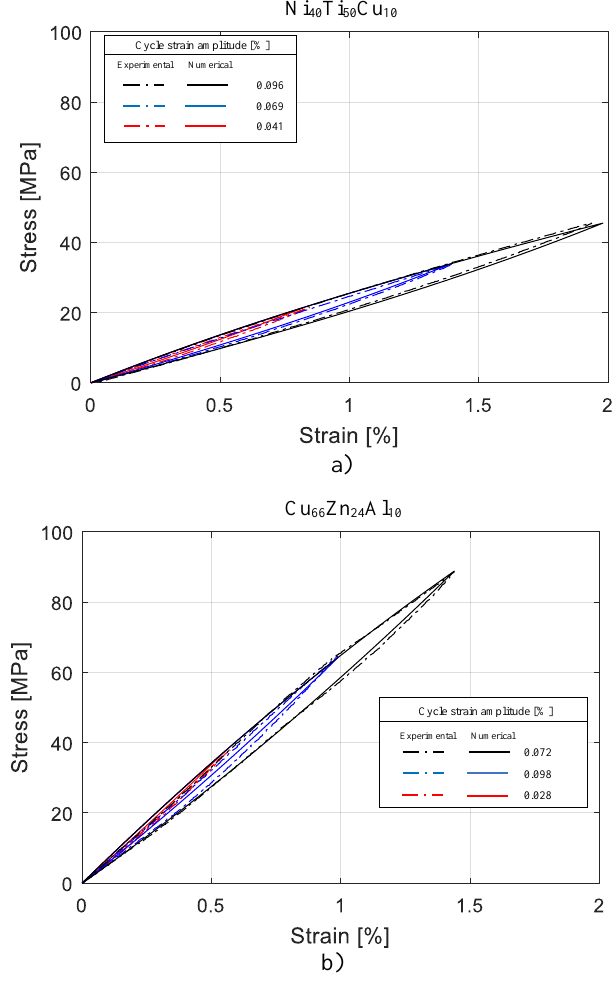
Figure 7. Comparison between experimental and numerical hysteresis cycles: ( a ) Ni 40 Ti 50 Cu 10 ; ( b ) Cu 66 Zn 24 Al 10 . Table 3. Comparison of the loss factor and average elastic modulus of Ni 40 Ti 50 Cu 10 , for numerical and experimental hysteresis